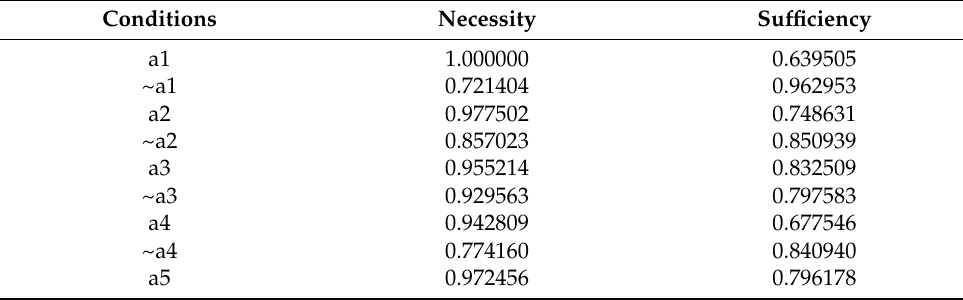
Table A11. Necessity and sufficiency analysis of conditions (outcome A3).